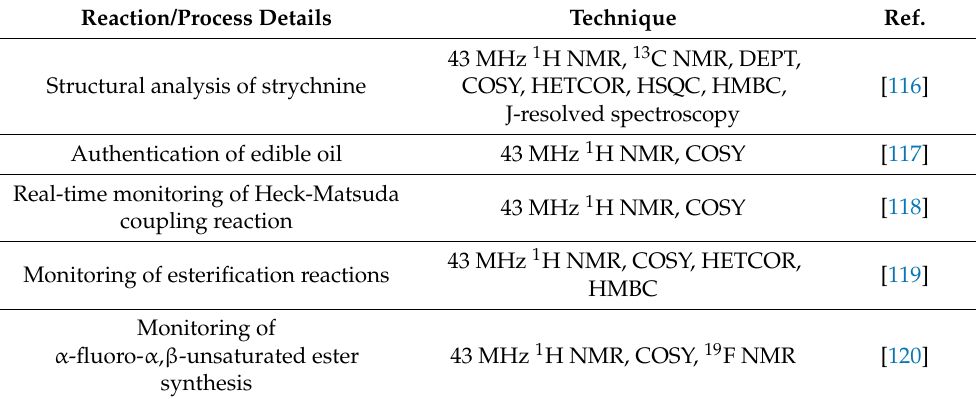
Table 8. Multidimensional techniques used in benchtop NMR spectroscopy. Reaction/Process Details